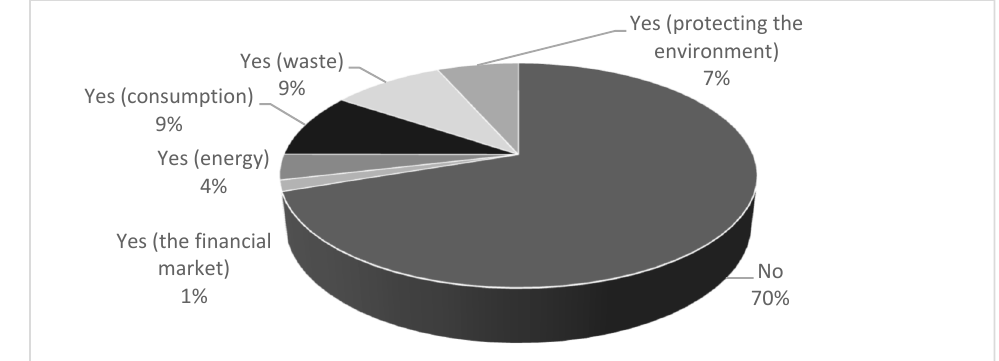
Figure 3. Survey responses to “Have you ever made a decision concerning pro-ecological actions which was connected to your private finance?” question. Source: own elaboration.